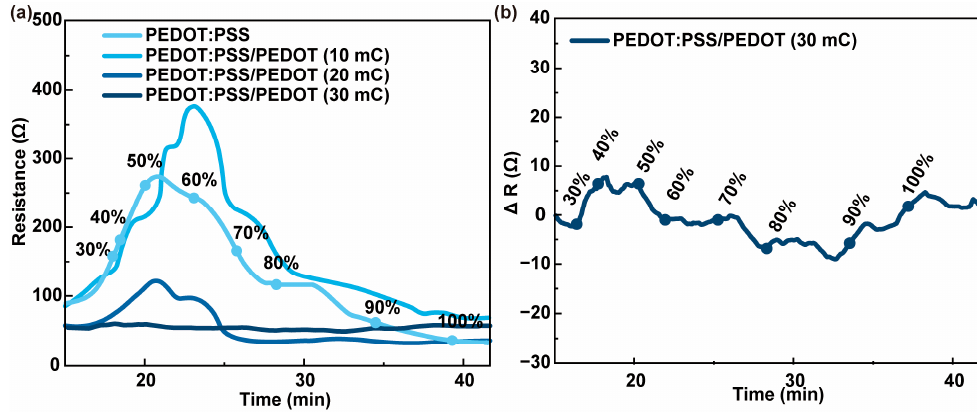
Figure 6. ( a ) Resistance-time curve of PEDOT:PSS and PEDOT:PSS/PEDOT films and ( b ) resistance change-time curve of PEDOT:PSS/PEDOT (30 mC) film under increased ambient humidity (30% RH~100% RH).